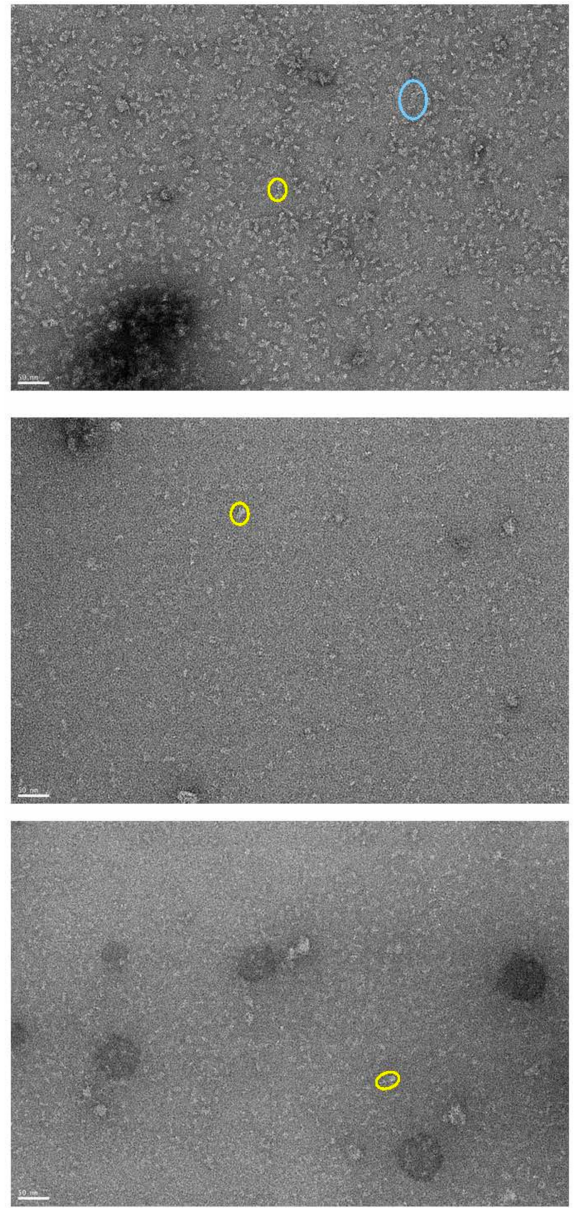
Figure 3. TEM pictures of MmPDE5A1 ( top ), A2 ( center ) and A3 ( bottom ) after negative staining and in the absence of ligands/effectors. In the cyan circle, there is one representative particle of tetramers; in the yellow circles, there are representative dimers. The scale bar is 50 nm, and magnification was 30,000 × . See Section 4.3 in methods for